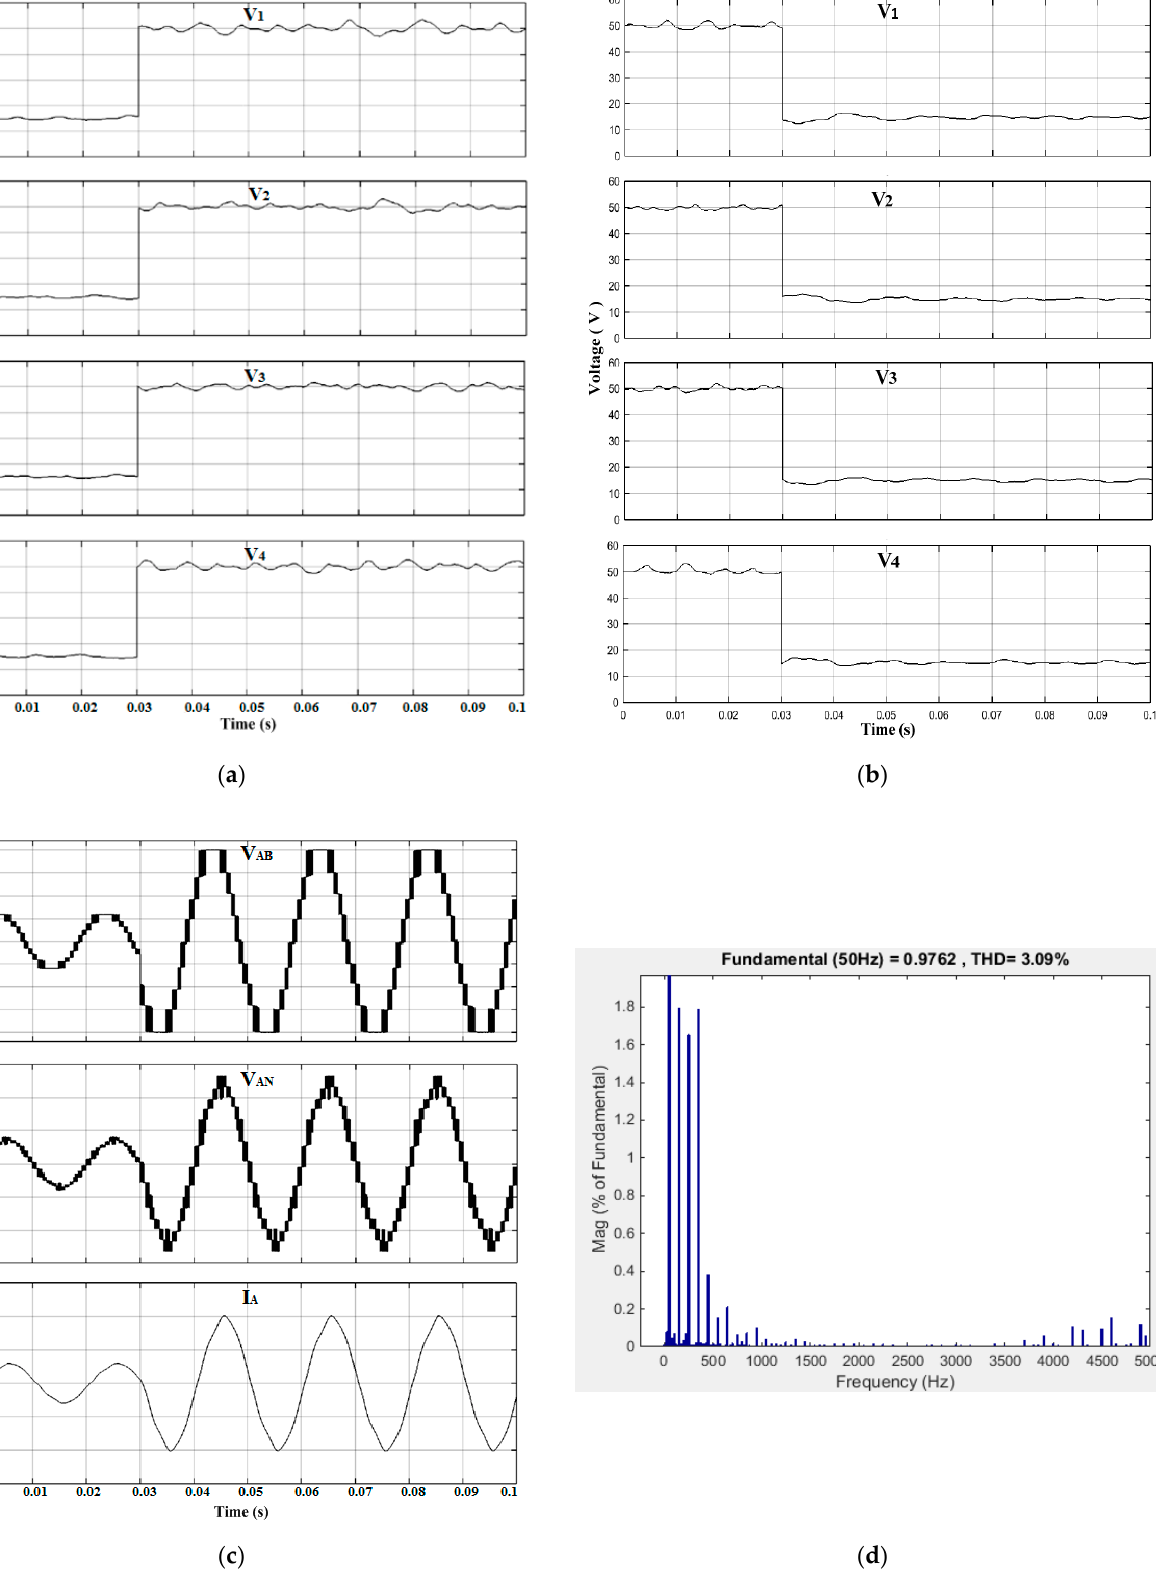
Figure 9. Simulation results with online tuning for a step response with V in changes from 60 V to 200 V. ( a ) Capacitor voltages (V 1 , V 2 , V 3 , V 4 ) for step-up response. ( b ) Capacitor voltages (V 1 , V 2 , V 3 , V 4 ) for step-down response. ( c ) Line-to-line output voltage (V AB ), phase voltage (V AN ) and output current (I A ). ( d ) Output current